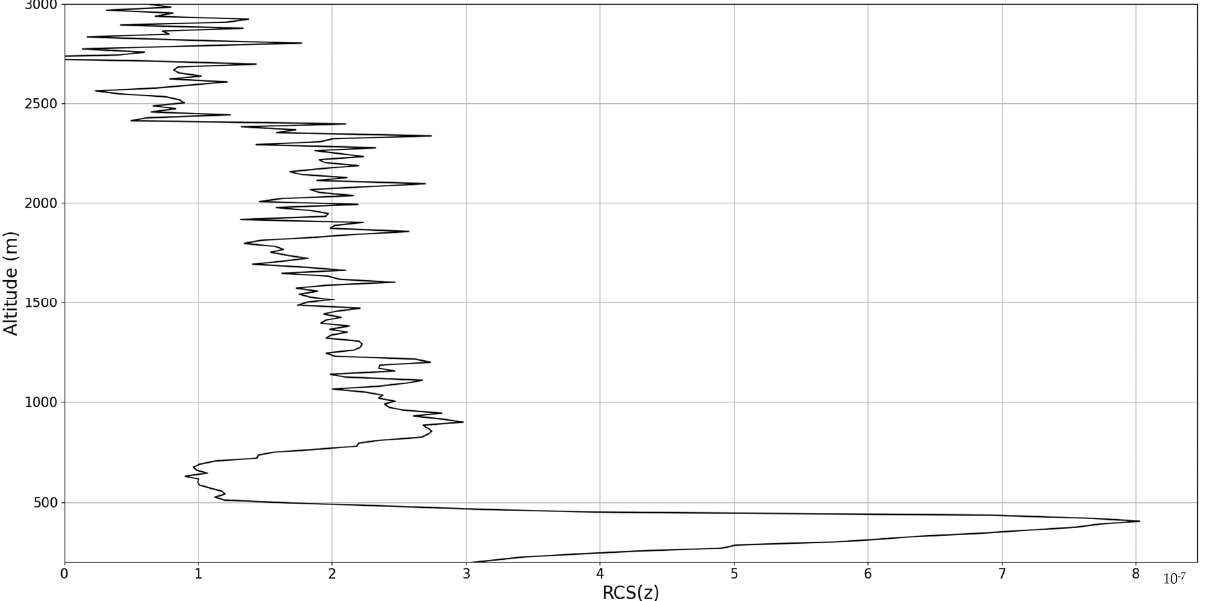
i, Romania, 22 December 2021. ,